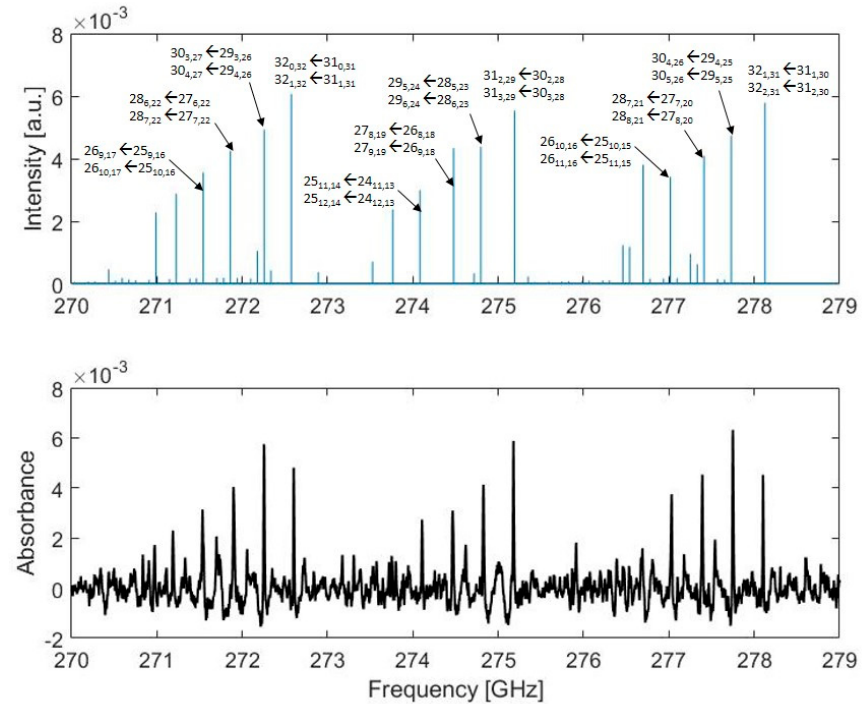
Figure 7. Comparison of measured absorbance (bottom) with line positions and intensities for the ground vibrational state simulated using PGOPHER [33] and the rotational constants of Cuisset et al. [27] in the 270–279 GHz frequency range.